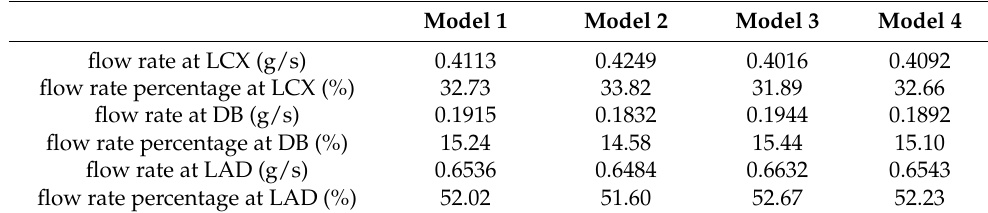
Figure 7. Flow rate distribution of each branch: ( a ) LCX, ( b ) LAD, and ( c ) DB. Table 1. Blood flow rate of each branch in different models.